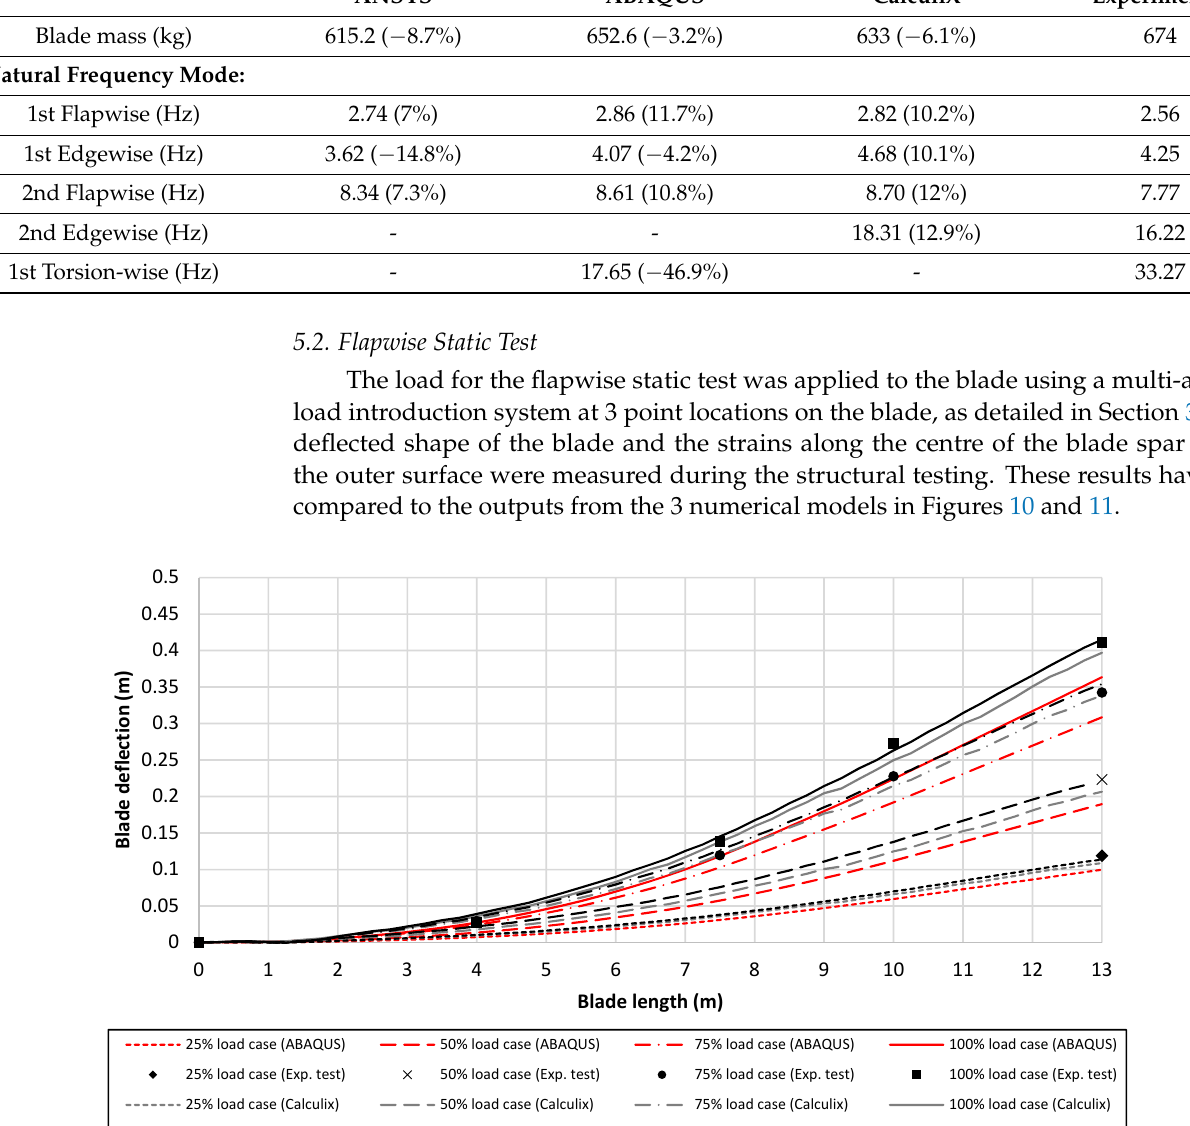
Table 3. Comparison of the blade mass and natural frequencies between results from the three numerical models and the experimental testing. ANSYS ABAQUS CalculiX